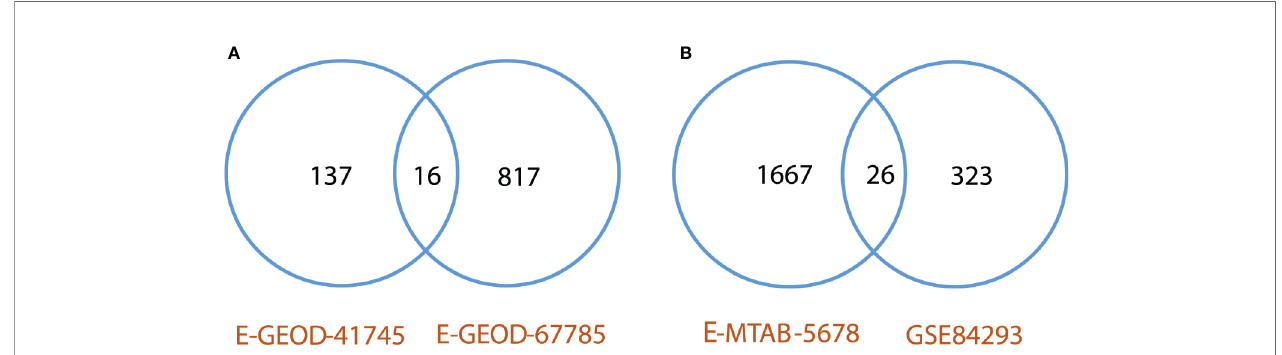
FIGURE 2 | (A) Comparative analysis of RNA-seq datasets of psoriasis. The analysis revealed 16 common DEGs between psoriasis datasets, and, 137 and 817 unique identi fi ed DEGs from datasets E-GEOD-41745 and E-GEOD-67785, respectively. (B) Comparative analysis of RNA-seq datasets of cSCC. The analysis revealed 26 common DEGs between cSCC datasets, and, 1667 and 323 unique identi fi ed DEGs from datasets E-MTAB-5678 and